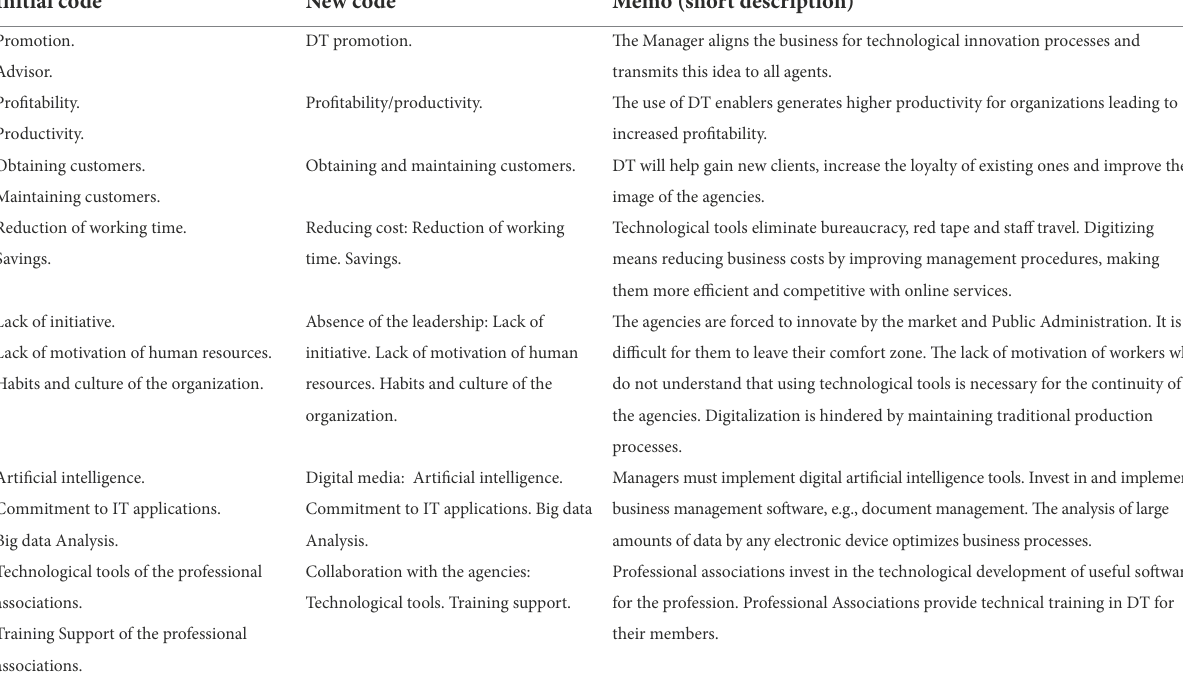
TABLE 4 New codes developed from the initial